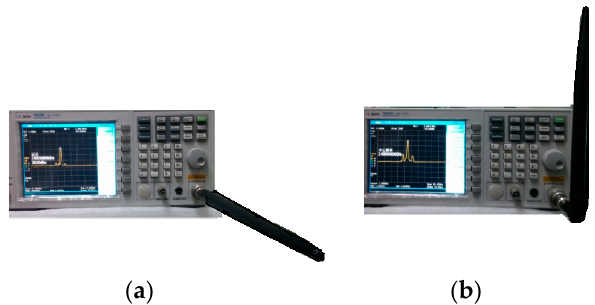
Figure 20. Receiving antenna power map. ( a ) parallel attitude; ( b ) vertical attitude.